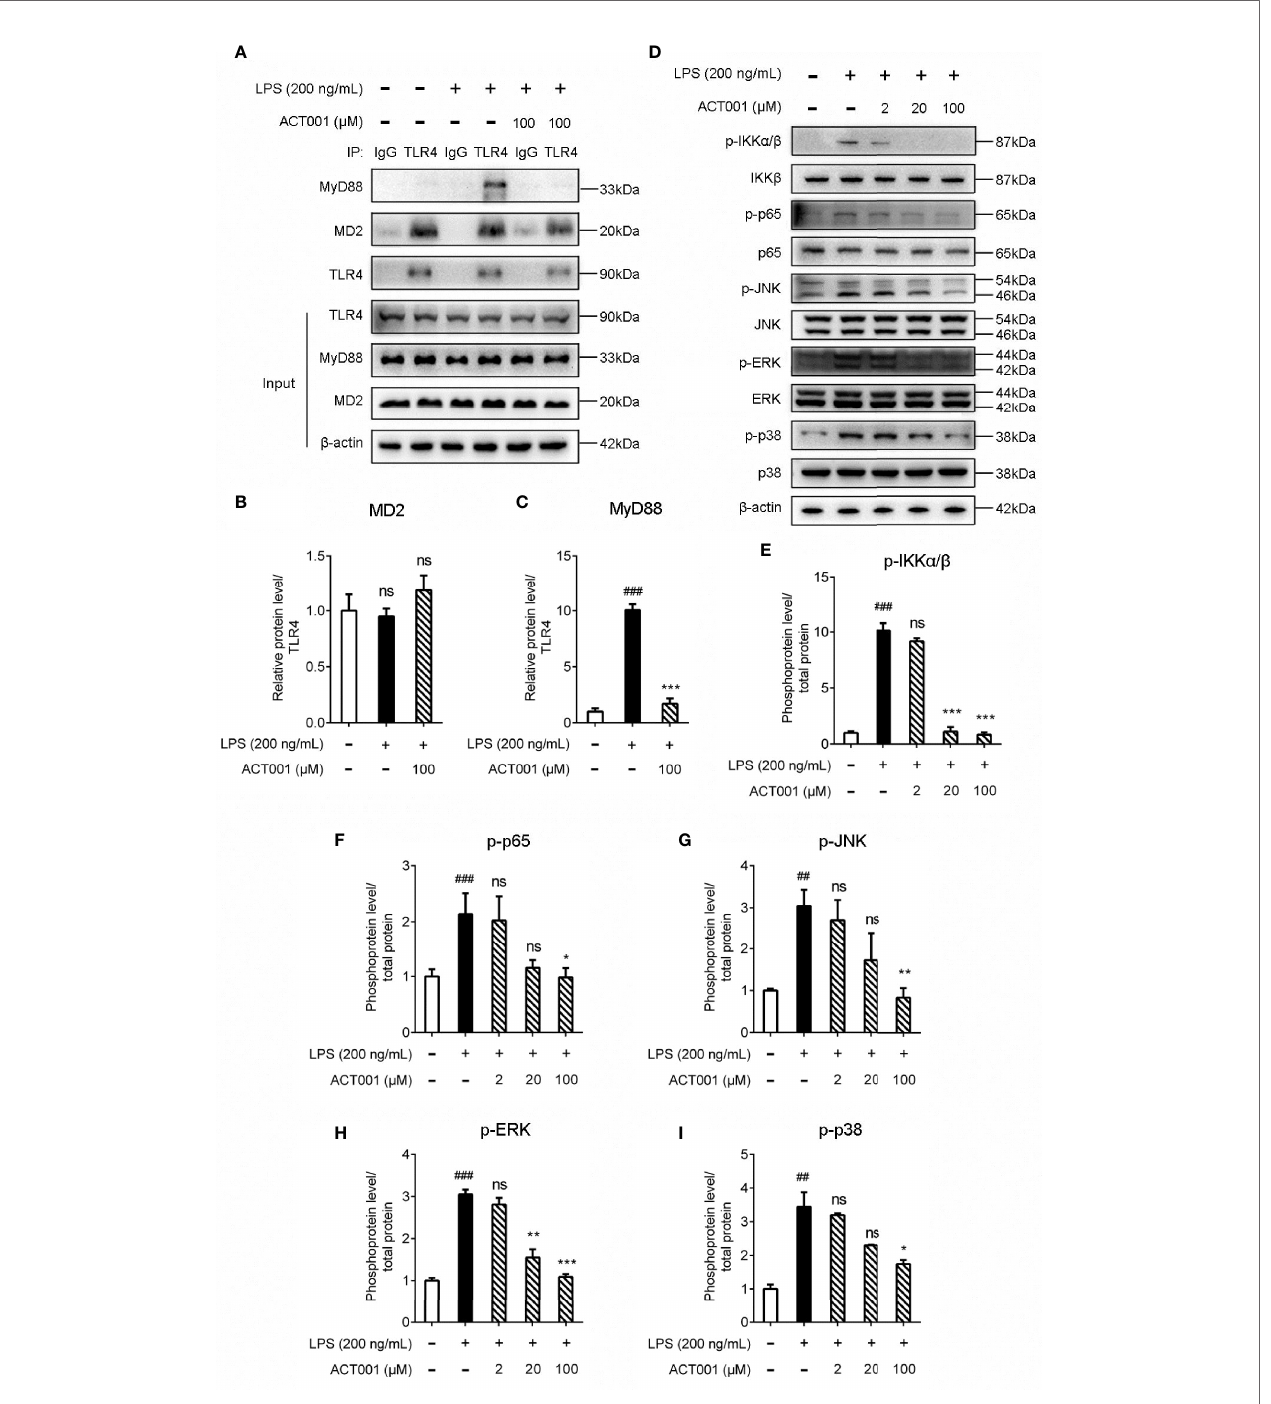
FIGURE 3 | Cellular characterizations of ACT001 on TLR4 signaling. BV-2 cells were administered with 200 ng/mL LPS and the indicated concentration of ACT001 for 1 h. (A-C) Co-immunoprecipitation of anti-TLR4 antibody, MD2, TLR4, and MyD88 were detected by immunoblotting. (D-I) The effect of ACT001 on LPS- induced phosphorylation of IKK b , p65 and MAPKs. The total protein level of IKK b , p65 and MAPKs was set as reference. All experiments were performed three times independently, and data were given as the mean ± SEM. ## P< 0.01, ### P< 0.001 versus the control; *P< 0.05, **P< 0.01, ***P< 0.001 versus the LPS group; ns, not signi fi